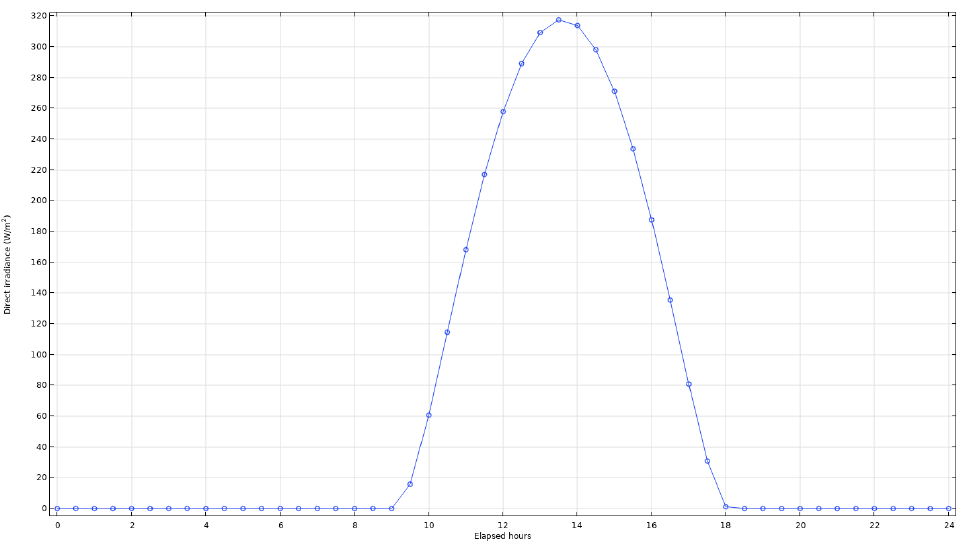
Figure 11. Direct Irradiance (Wm − 2 ) received by the cell at 2019’s winter solstice, referent to the wings.